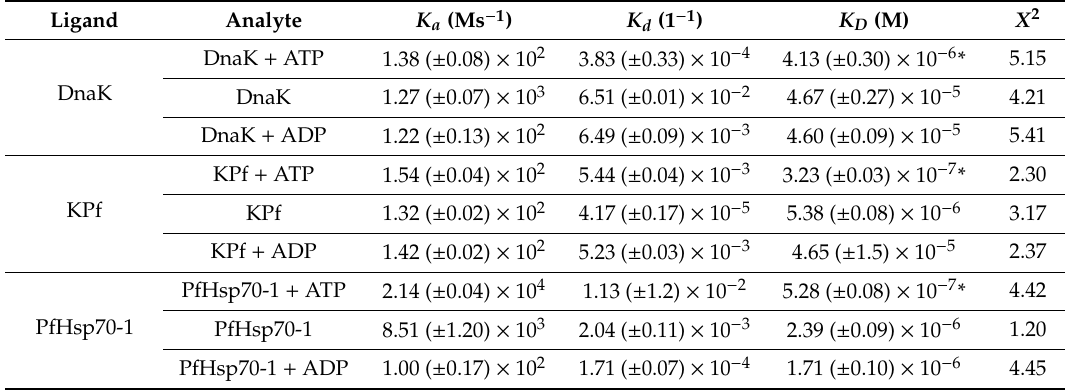
Table 1. Kinetics for self-association of DnaK, KPf and